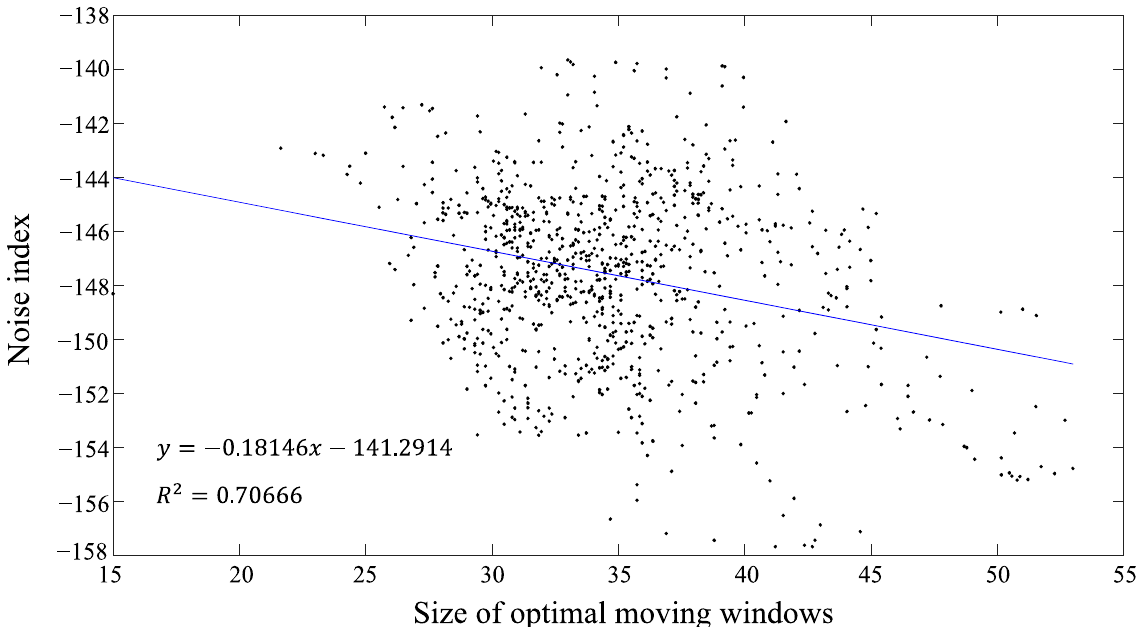
Figure 3. Scatter diagram of moving windows and noise.